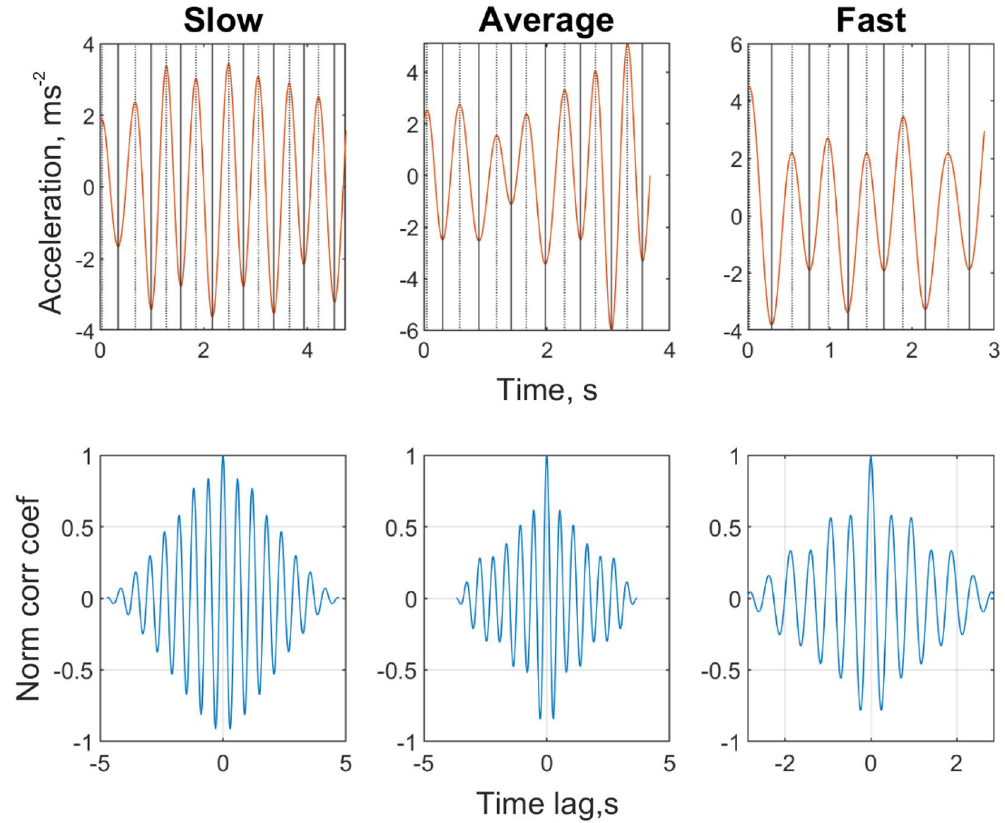
Figure 2. An example of the time-series of the static noise-removed bandpass-filtered Euclidean norm of the acceleration vectors and autocorrelation functions for walking with arm-swing at slow, usual and fast paces.